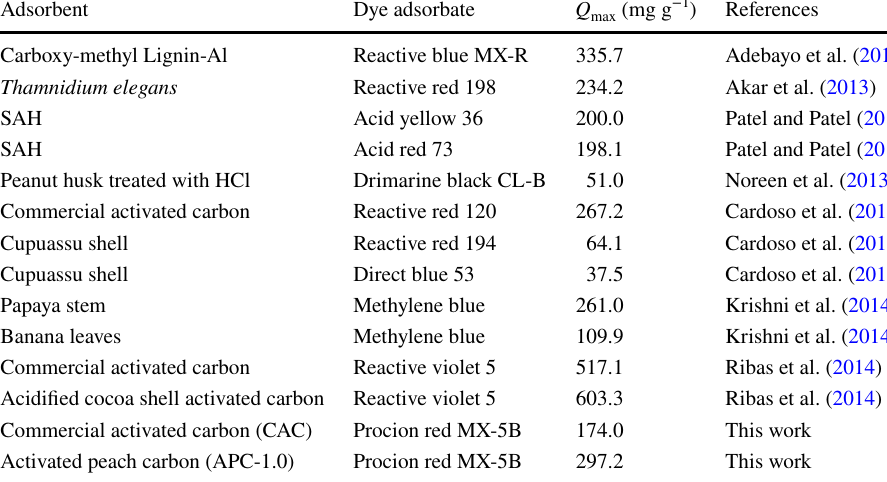
capacities of different adsorbents used for removal of various